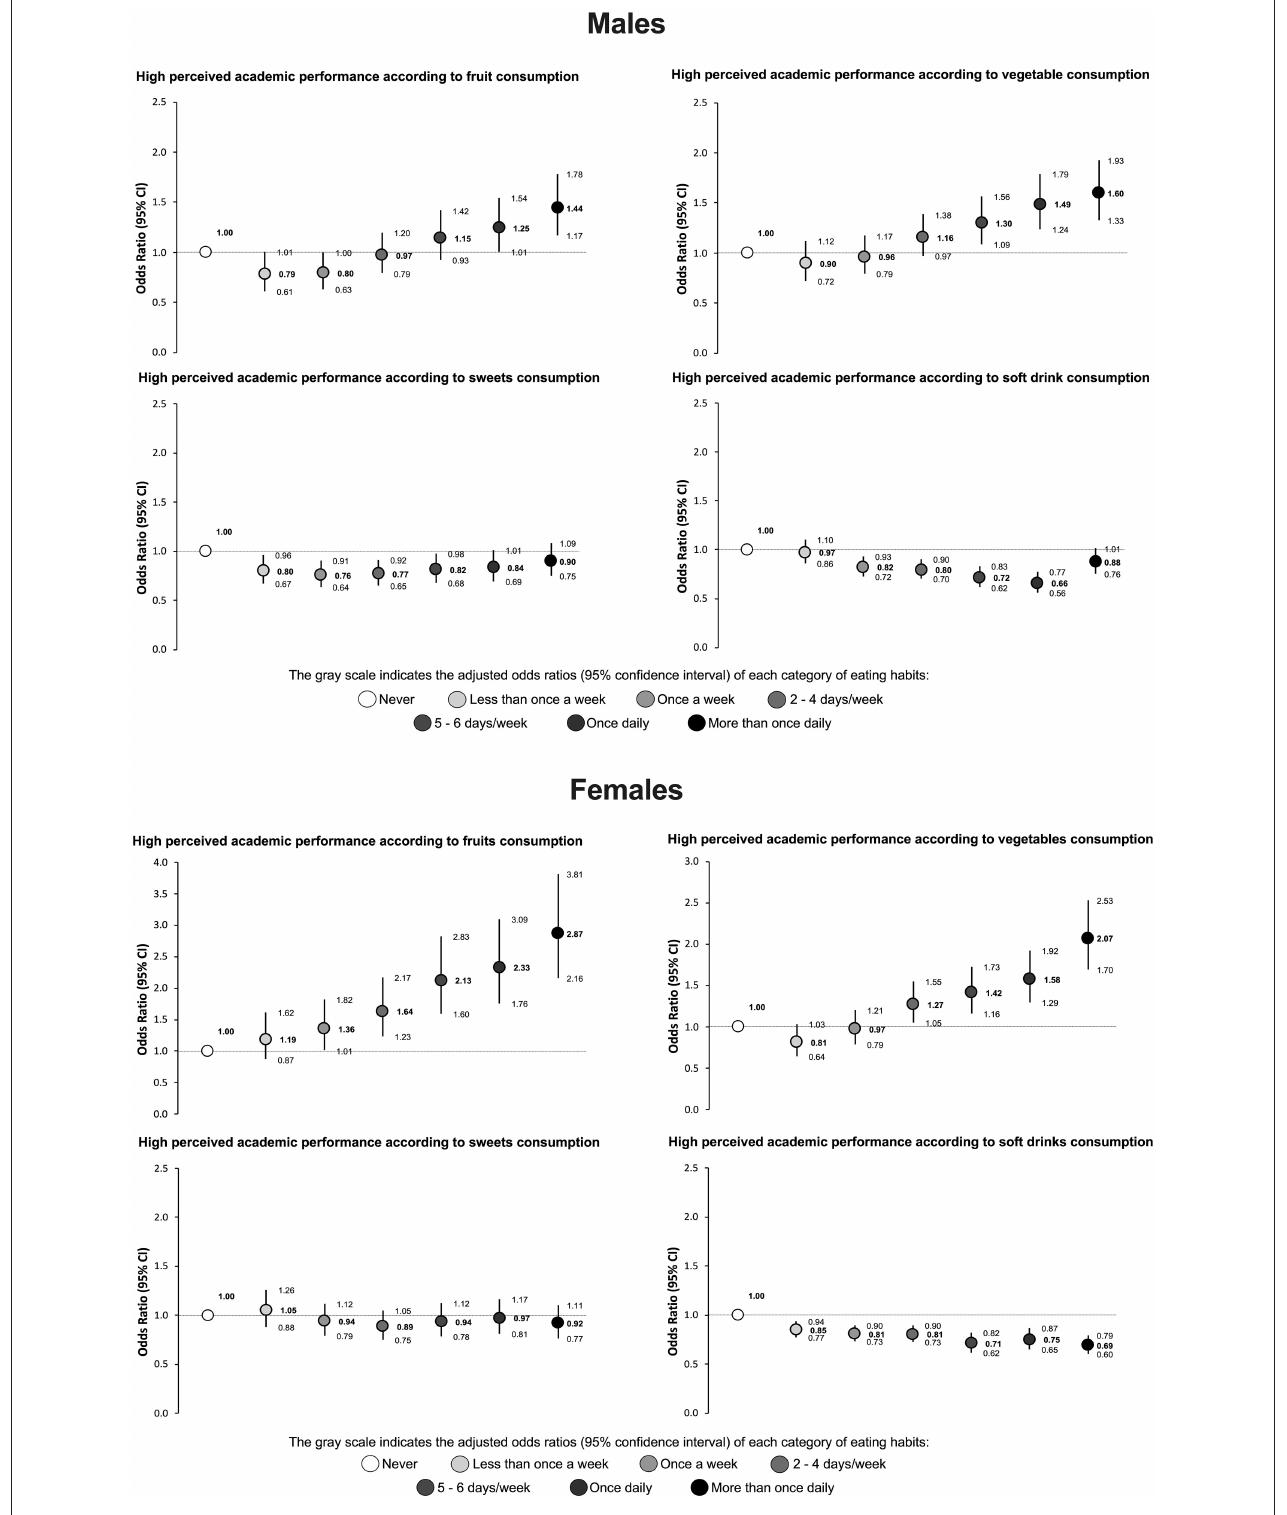
FIGURE 1 | Association between high perceived academic performance and fruit, vegetable, sweets, and soft drink consumption among adolescents. Odds ratios generated using logistic regression models adjusted by region, age, body mass index (z-score), socioeconomic status, physical activity, recreational screen time, and sleep